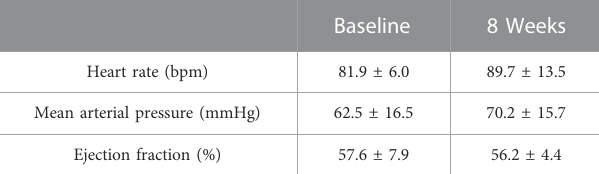
TABLE 1Hemodynamicparameters. In terms ofheartrate,blood pressure, and ejection fraction, no statistically signi fi cant difference was found between baseline and termination ( p > 0.05, t-test) for any of the